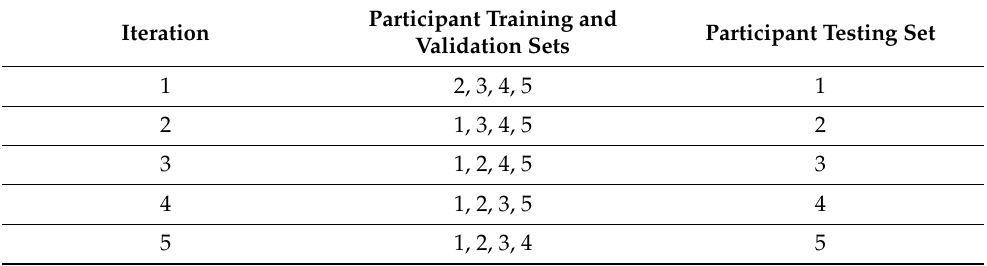
Table 2. Training, validation, and test sets. Each classifier was trained five times, each time using a different Participant set as the test data and the remaining sets as the training and validation sets. Participant Training and Participant Testing Iteration Validation Sets